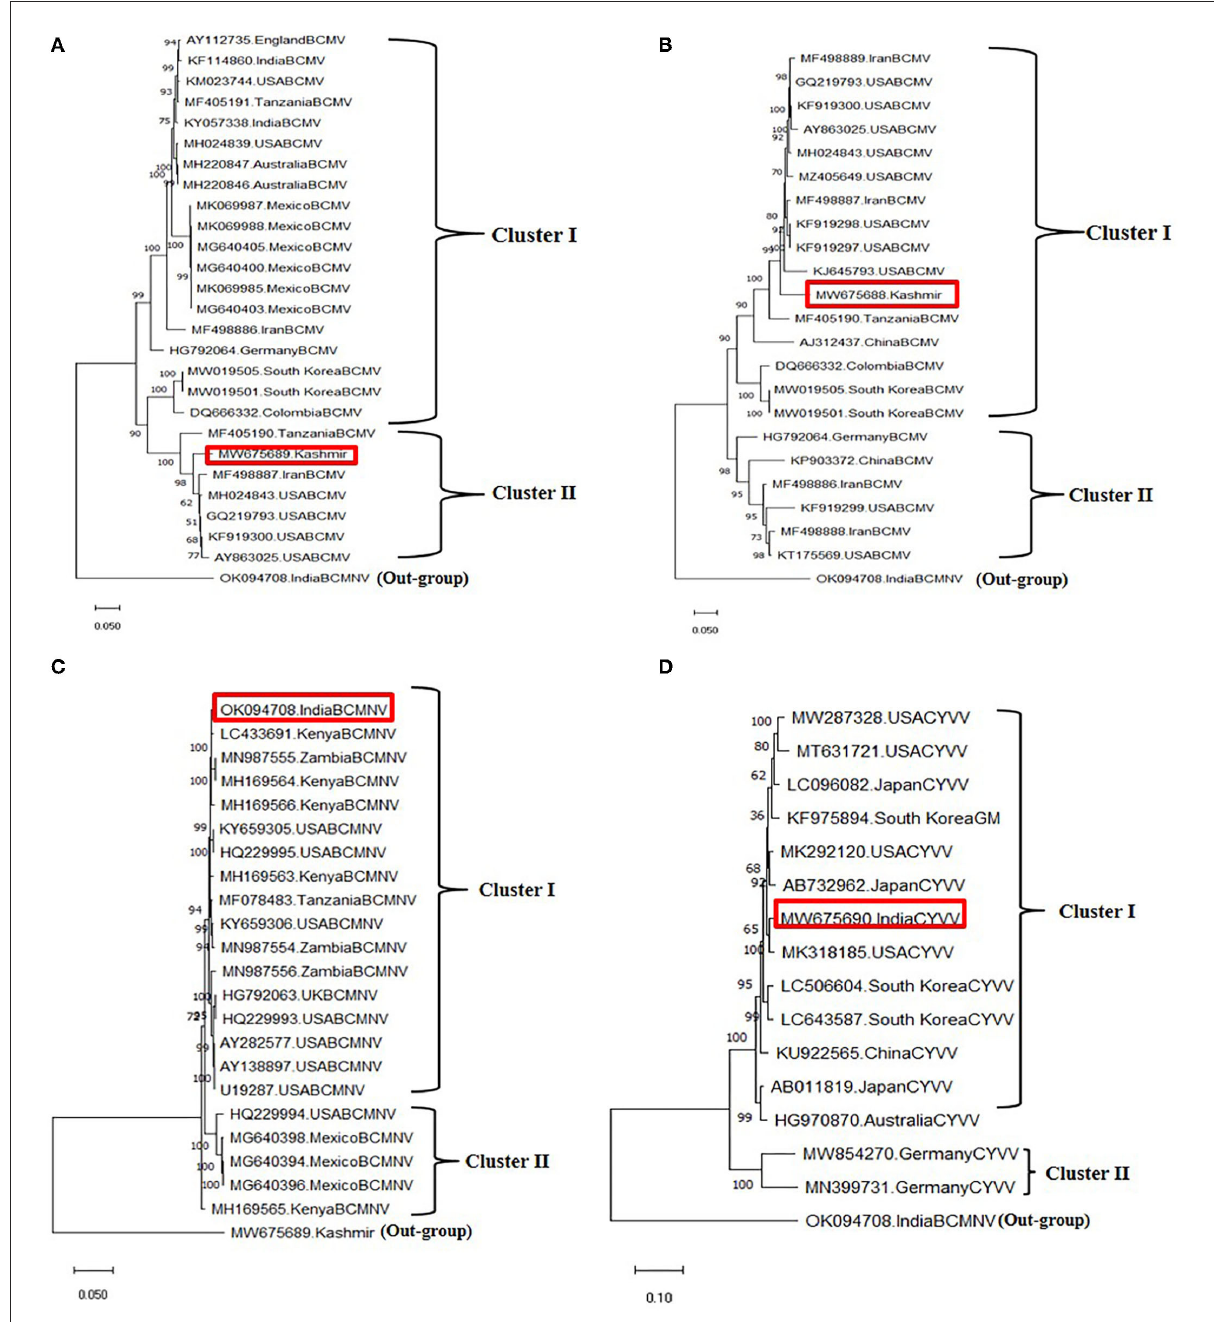
FIGURE5 Phylogenetic analysis of identified viruses using whole genomes through maximum likelihood method using the MEGA X software. The scale indicates the number of substitutions per site. Highlighted in red in phylogeny represents the isolates of the present study. (A) Phylogenetic tree of BCMV 1, (B) phylogenetic tree of BCMV 2, (C) phylogenetic tree of BCMNV, and (D) phylogenetic tree